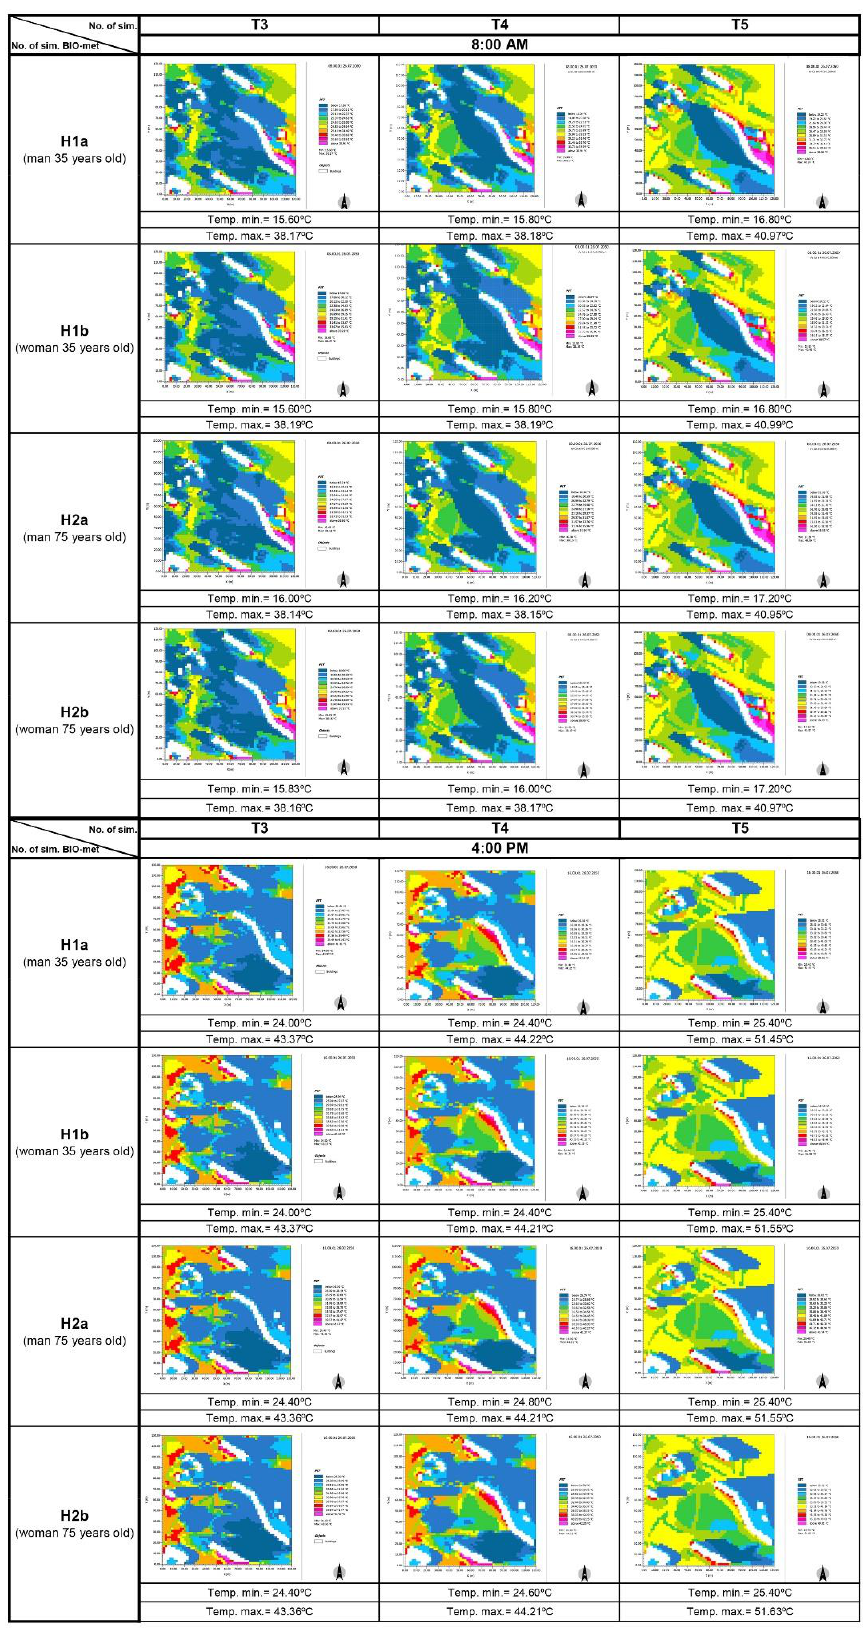
Figure 13. Comparison of BIO-met speculation for 8:00 a.m. and 4:00 p.m. T3 with T4 (no vegetation in the square) and T5 (no vegetation in the whole area).